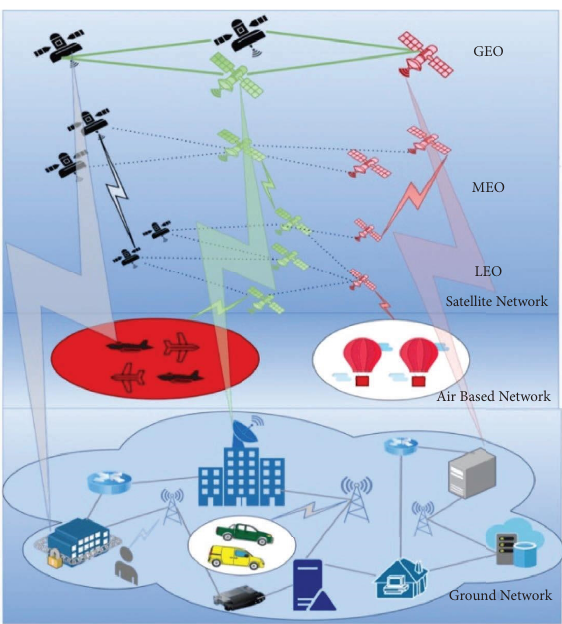
Figure 1: Space-air-ground integrated network